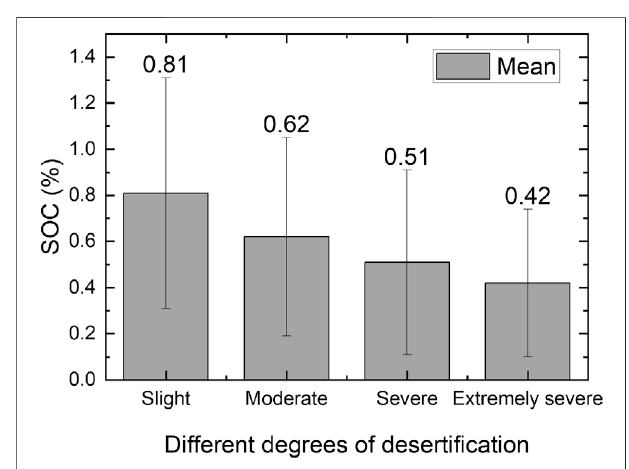
FIGURE 7 | Mean SOM content in different stages of deserti fi cation (error bars: standard